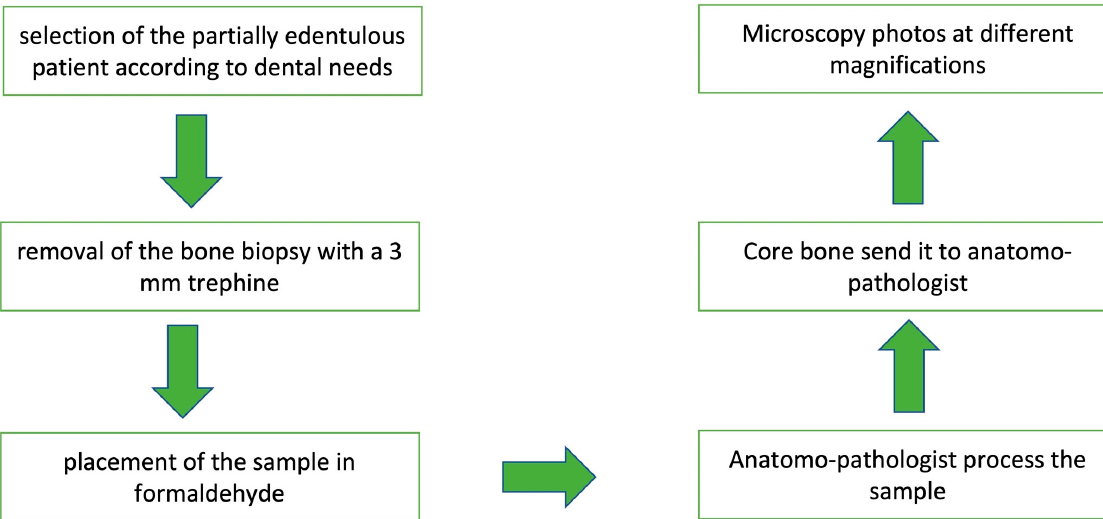
Diagram 2: Design of patient selection and biopsy extraction. Chart 2. Design of patient selection and biopsy